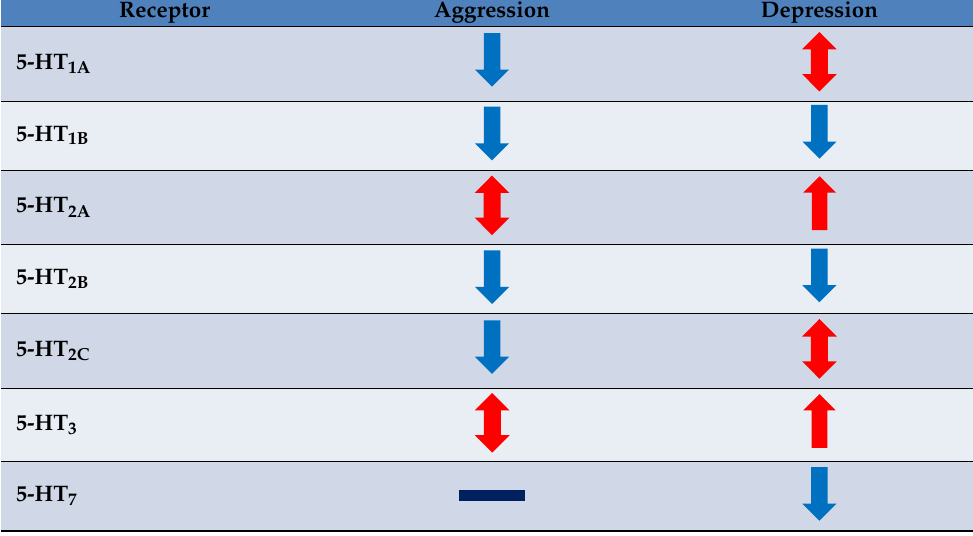
Table 1. Summarized effects of 5-HT receptors on aggression and depression. Activating effect is shown by up arrow; suppressing effect is shown by down arrow; bidirectional effect is shown by double arrow; no effect is shown by straight line.